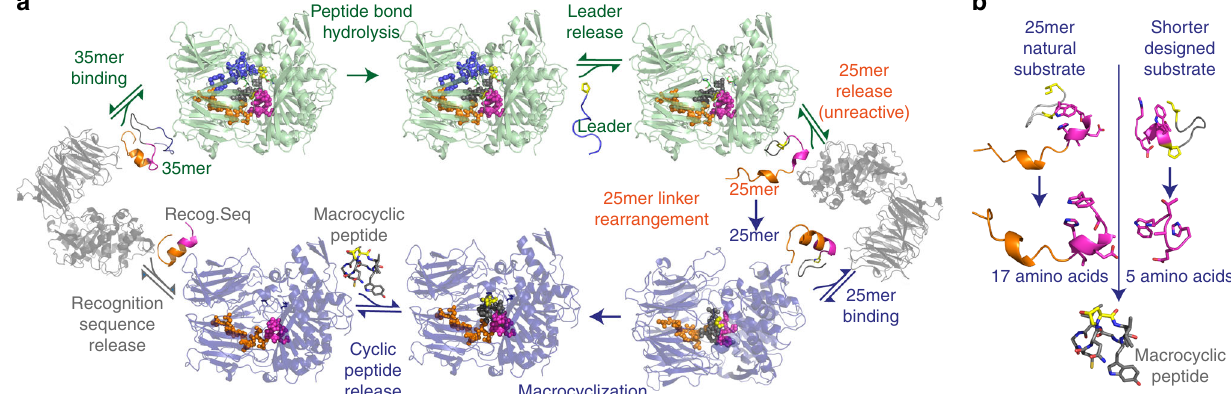
Fig. 4 GmPOPB catalyzes peptide bond hydrolysis and macrocyclization. a The sequence of events catalyzed by GmPOPB starting with the 35mer peptide substrate. Peptide bond hydrolysis yields the leader sequence (which dissociates) and the 25mer peptide. The enzyme-bound 25mer is conformationally trapped and macrocyclization cannot proceed. The 25mer must dissociate to rearrange and re-bind only then does macrocyclization occur. Apo enzyme is shown in gray , the enzyme functioning as a protease is colored green , and functioning as a macrocyclase in blue . The peptide is colored as Fig. 1b. b A 25mer substrate yields a 17 amino-acid by-product, whereas the 13mer substrate generates a 5 amino-acid by-product, a much more economically ef fi cient reaction. Substrates are colored as Fig.